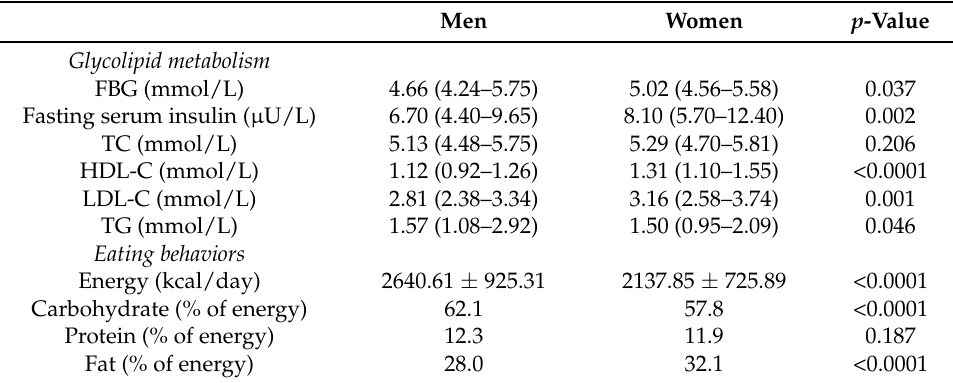
Table 2. Glycolipid metabolism and eating behaviors of the study